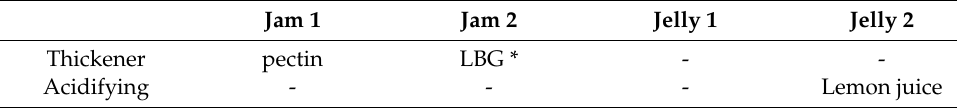
Table 1. Ingredients used and codification of samples. Jam 1 Jam 2 Jelly 1 Jelly 2 Thickener pectin